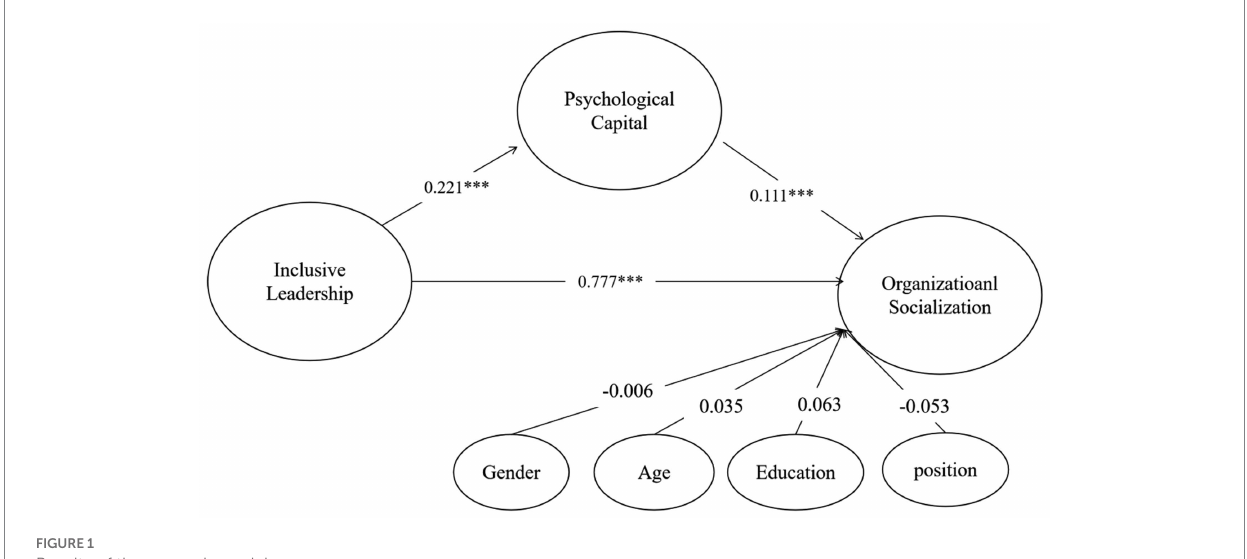
FIGURE 1 Results of the research model.